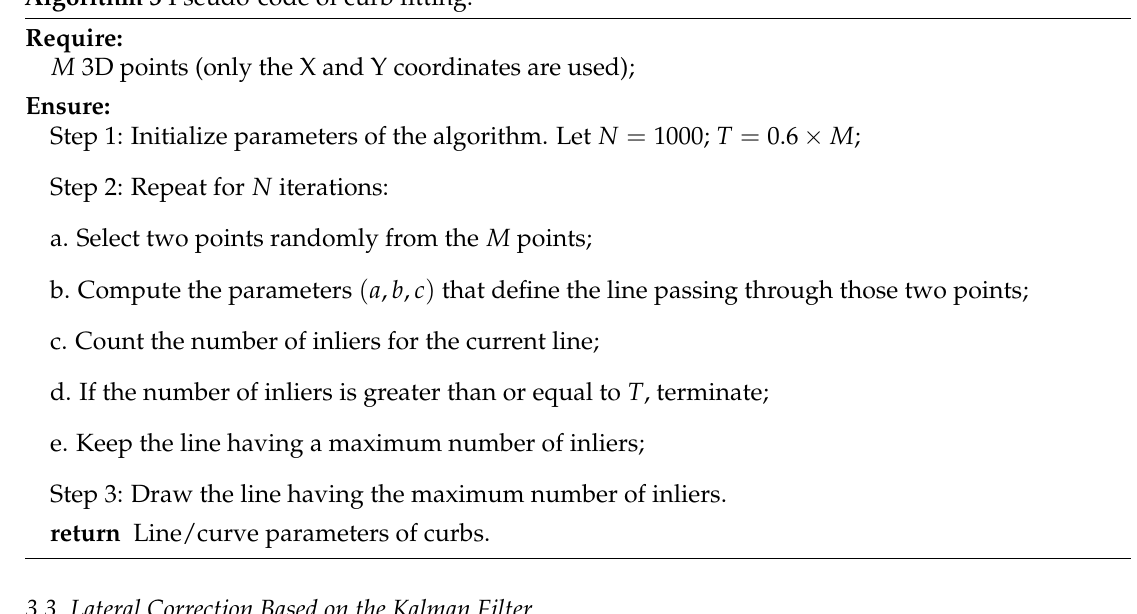
Algorithm 3 Pseudo-code of curb fitting.